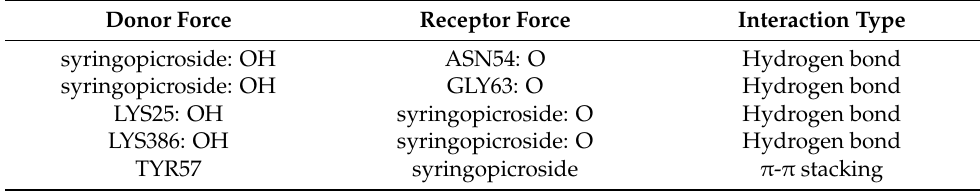
Table 3. The specific interaction forms between syringopicroside and the Orfy